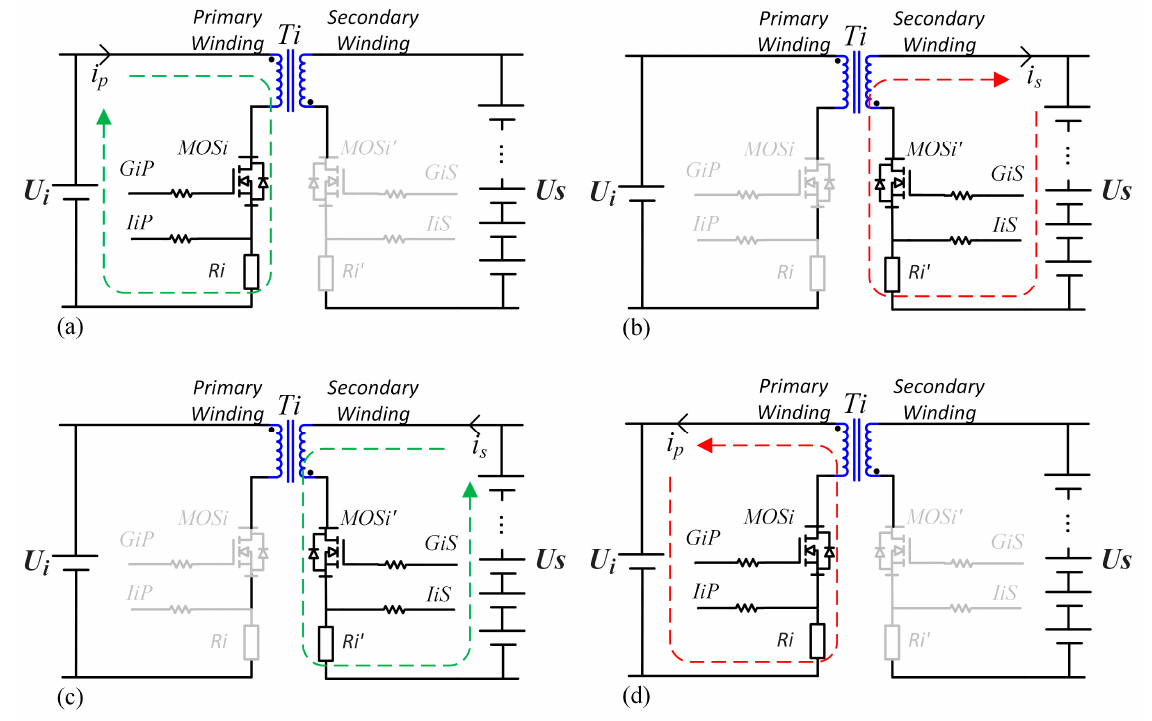
Figure 3. Equalizer operating modes; ( a ) cell-to-String (C2S) mode: cell is discharged; ( b ) C2S mode: string is charged; ( c ) S2C mode: string is discharged; ( d ) S2C mode: cell is charged.